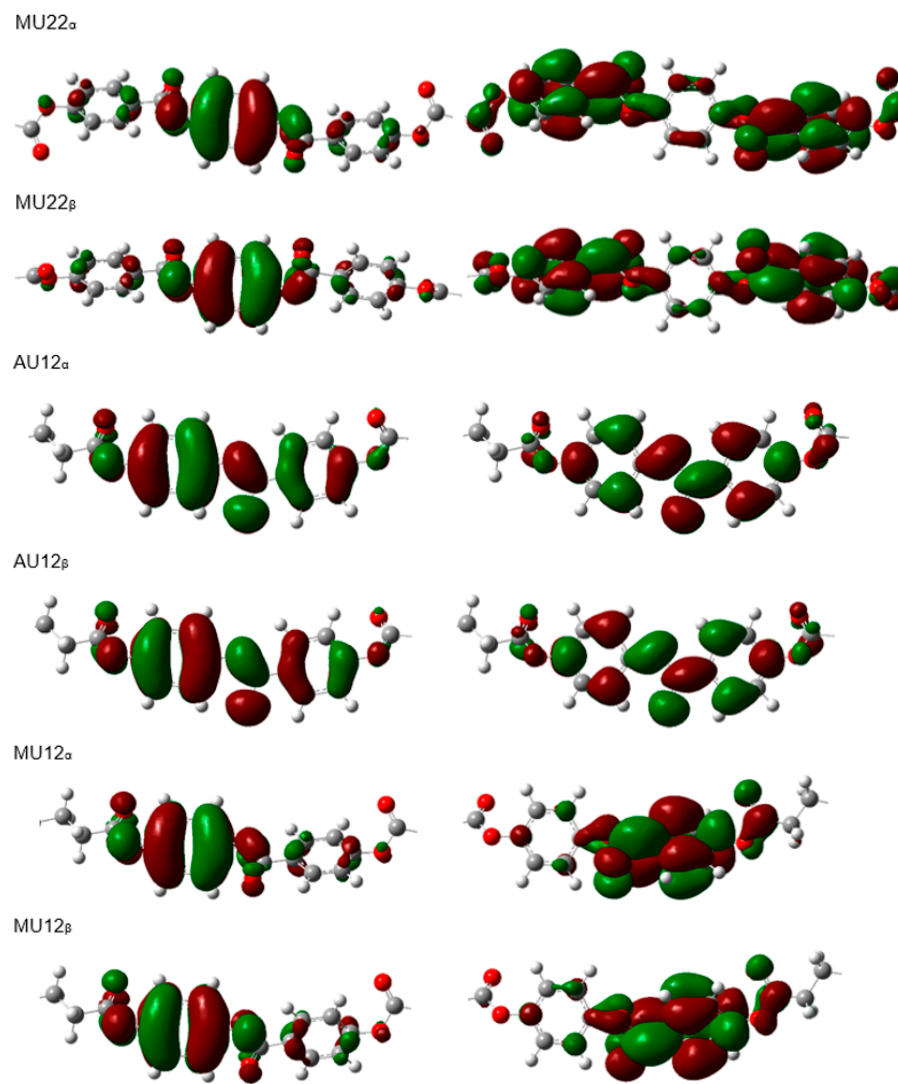
Figure 4. Visualization of frontier molecular orbitals—HOMO ( left ) and LUMO ( right )—of the epoxy molecules: MU22, AU12 and MU12. Only the relevant, central parts of the molecules are shown. The terminal chains are excluded from the figure because only the central segment (which is identical in each epoxy and vinyl pair) participates in shaping the frontier